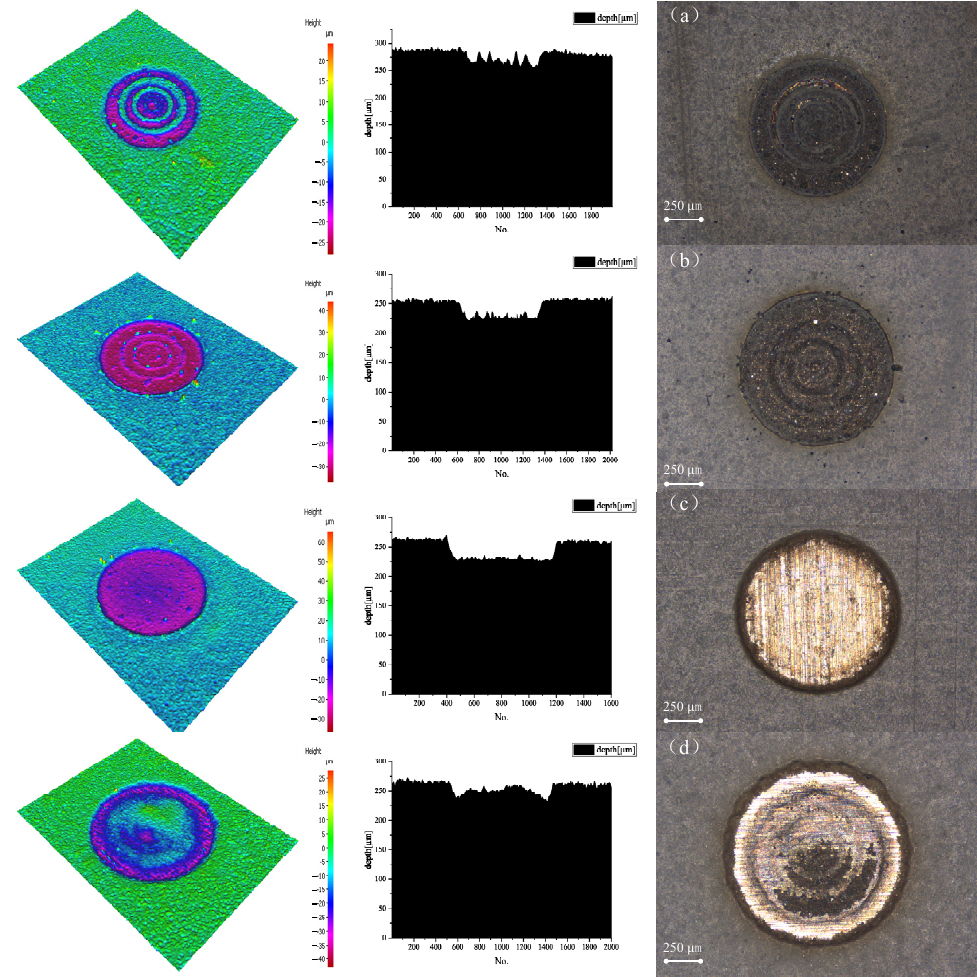
Figure 6. Cleaning effect under different power densities. ( a ) 36.41 W/mm 2 , ( b ) 187.54 W/mm 2 , ( c ) 192.90 W/mm 2 , ( d ) 353.07 W/mm 2 . ( c ) 192.90 W/mm 2 , ( d ) 353.07 W/mm 2